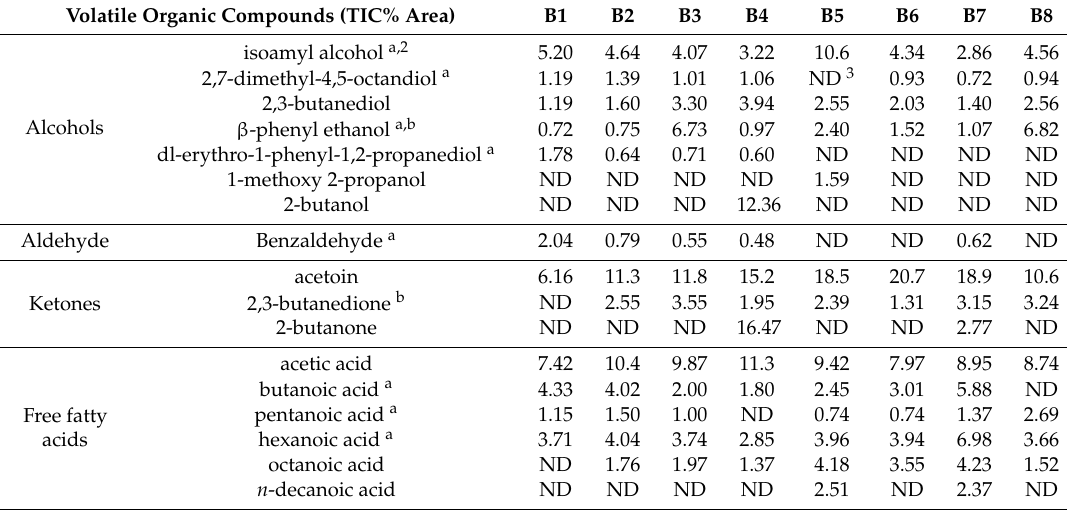
Table 5. Average chemical composition (TIC% Area) 1 of the bryndza cheese from producers B1–8 produced from May to September 2019 obtained by gas chromatography (GC–MS) analysis.